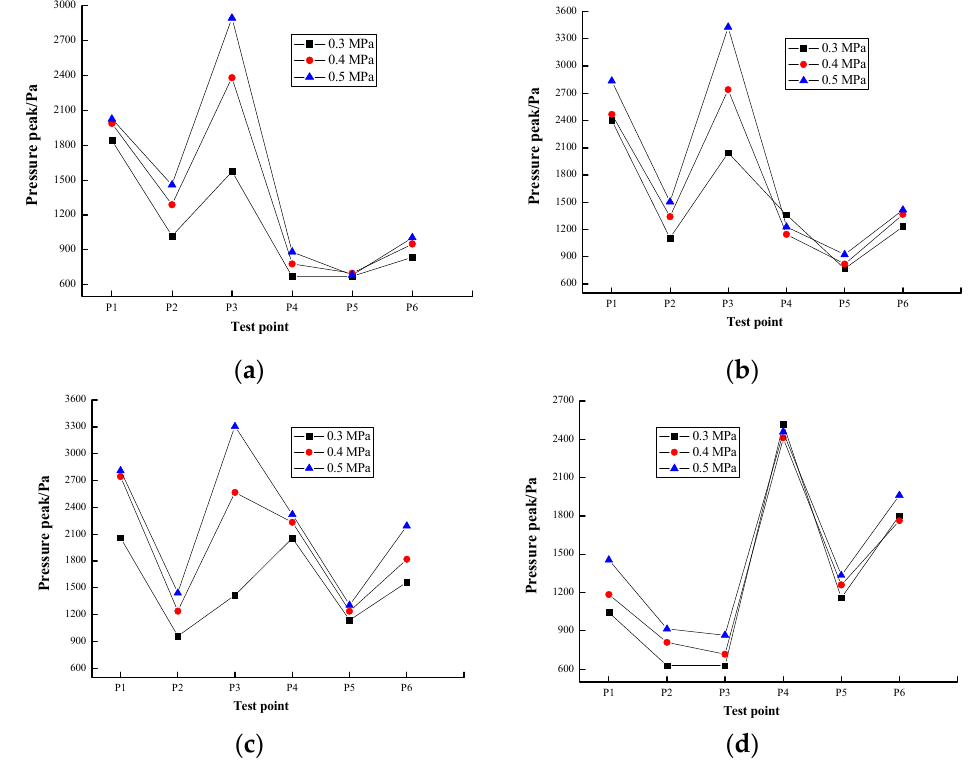
Figure 5. The change of the peak pressure on the sidewalls with different nozzle areas under different injection pressures. ( a ) Total nozzle area of 273 mm 2 . ( b ) Total nozzle area of 546 mm 2 . ( c ) Total nozzle area of 819 mm 2 . ( d ) Total nozzle area of 1365 mm 2 .